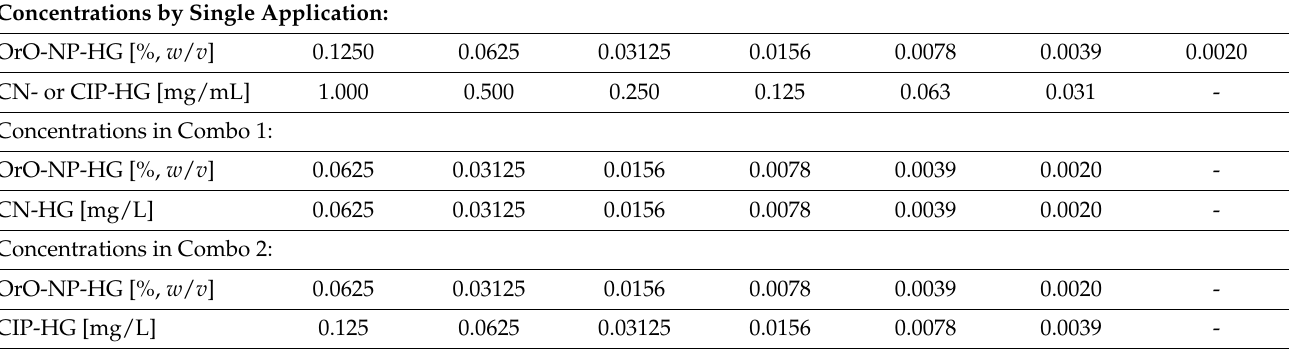
Table 4. Schema of the combinations between different concentration of OrO-NP-HG, CN-HG and CIP-HG tested on MSSA and